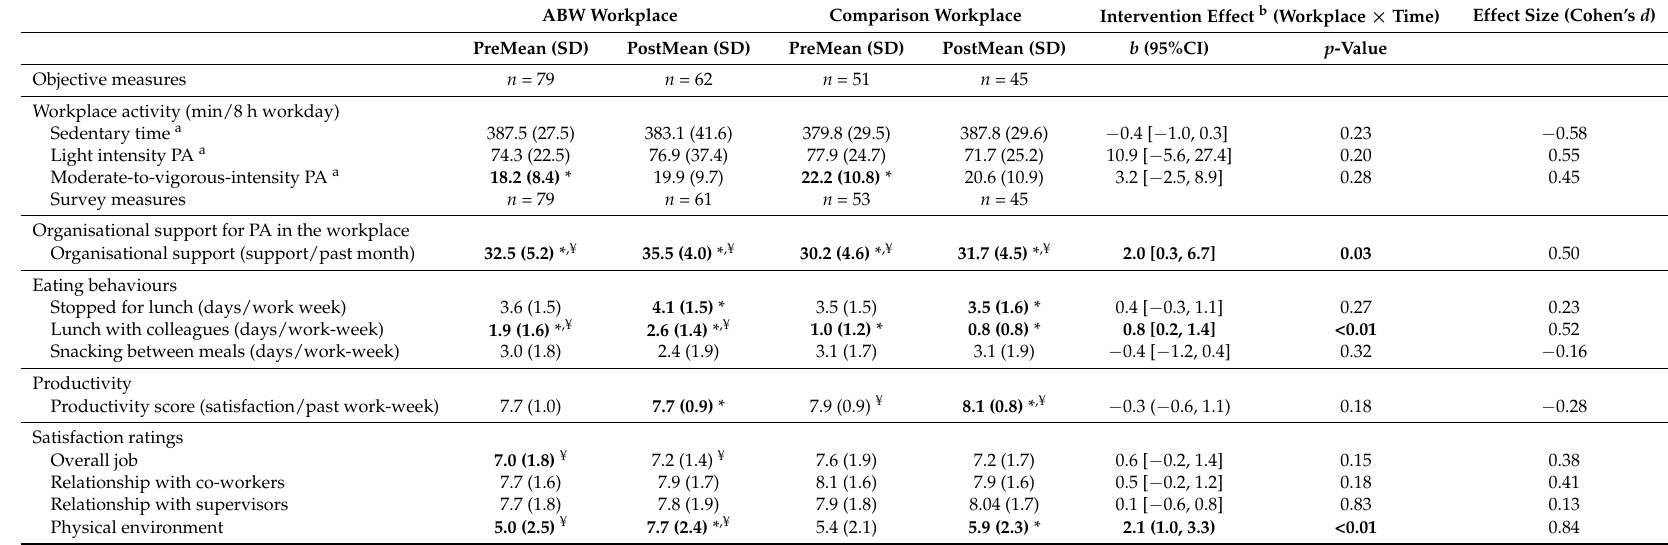
Table 2. Mixed models (coefficients [ b ] 95% CI, p -value) examining the impact of ABW on workplace activity, eating patterns, productivity, and workplace satisfaction outcomes. ABW Workplace Comparison Workplace Intervention Effect b (Workplace × Time) Effect Size (Cohen’s d